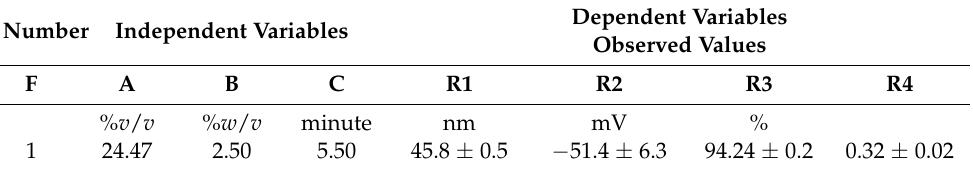
Table 6. The actual values of the optimized VT-ETH formulation.